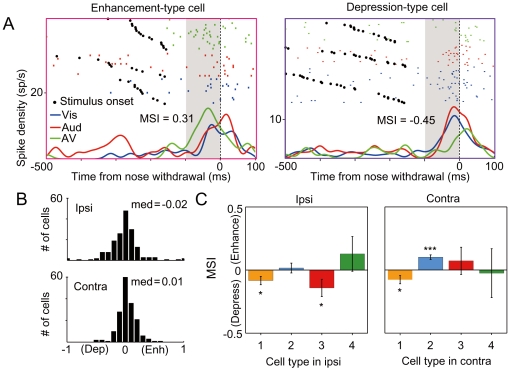
Enhancement and depression in premovement activity by multisensory stimuli.(A) Examples of neurons showing enhanced or depressed premovement activity for contraversive movement under audiovisual (AV) stimulus condition compared with those under visual (Vis) and auditory (Aud) stimulus conditions. MSI (multisensory modulation index, see Methods) in the premovement period for each neuron is shown. (B) Graphs show the distributions of MSIs in the premovement period for the ipsiversive and contraversive movements. (C) Mean MSI divided into cell type groups and directions of the movements, showing significant deviation from zero in some cell types (* p<0.05, ** p<0.01, *** p<0.001 in t-test).